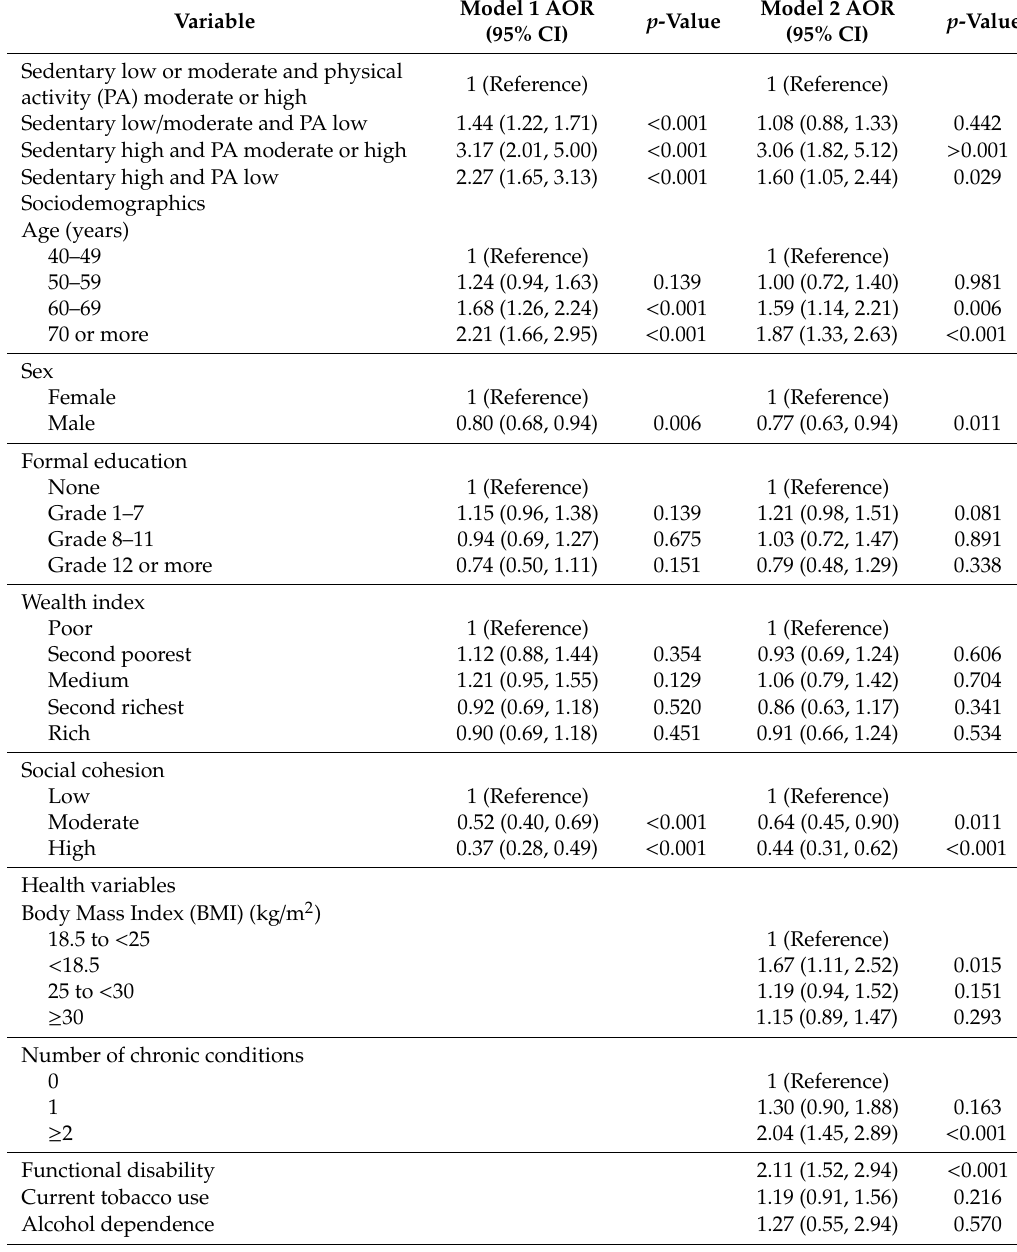
Table 3. Odds ratios for depression according to combined sedentary behavior and low physical